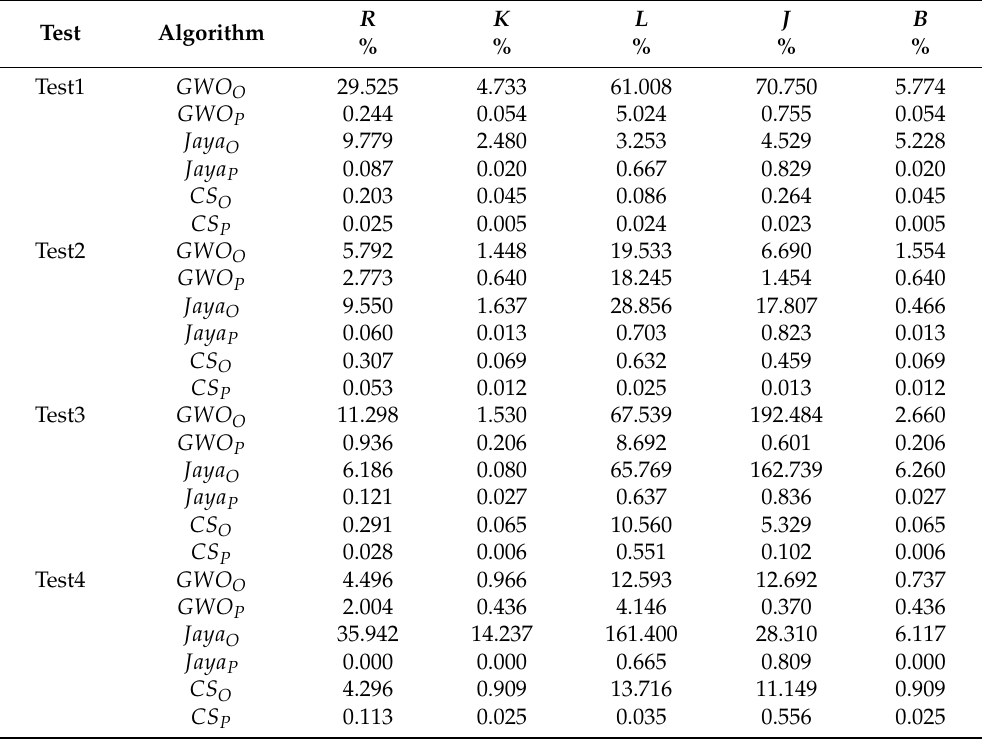
Table 6. The absolute percentage error for test in Motor